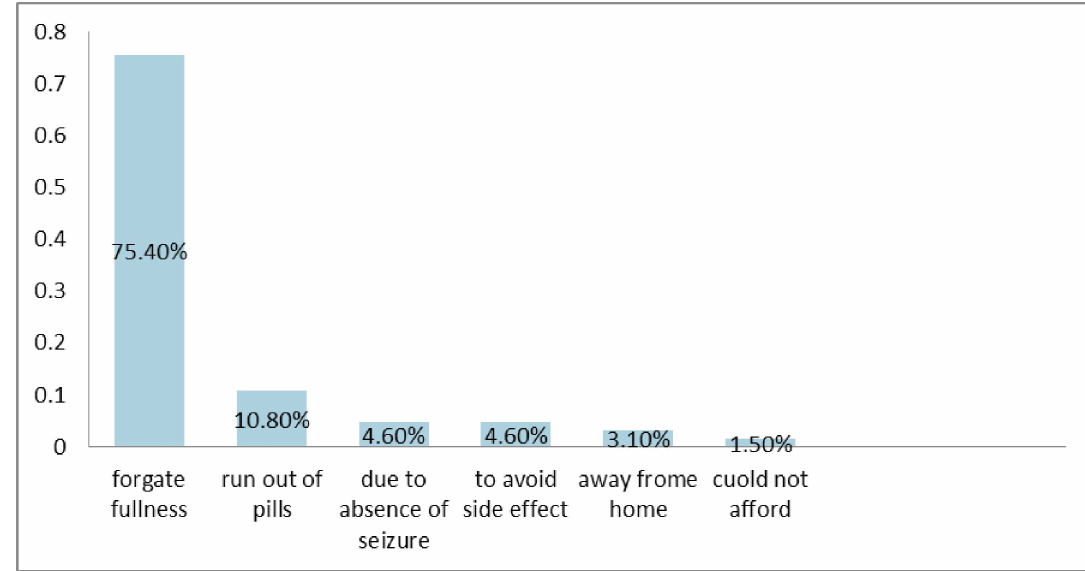
Fig 3. Self-reported reasons for medication non-adherence among epileptic patients at Yirgalem General Hospital.